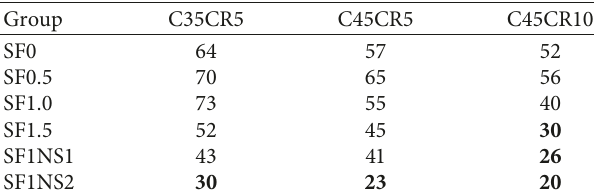
Table 2: The slumps of concrete mixtures (unit: mm).